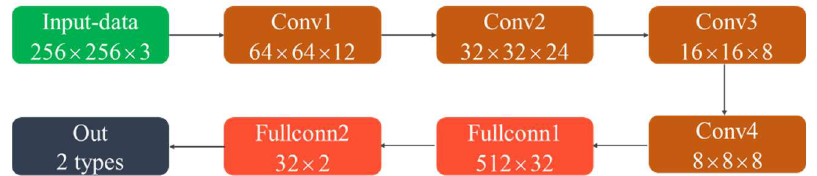
Figure 5. Structure of the CNN for path number discrimination.